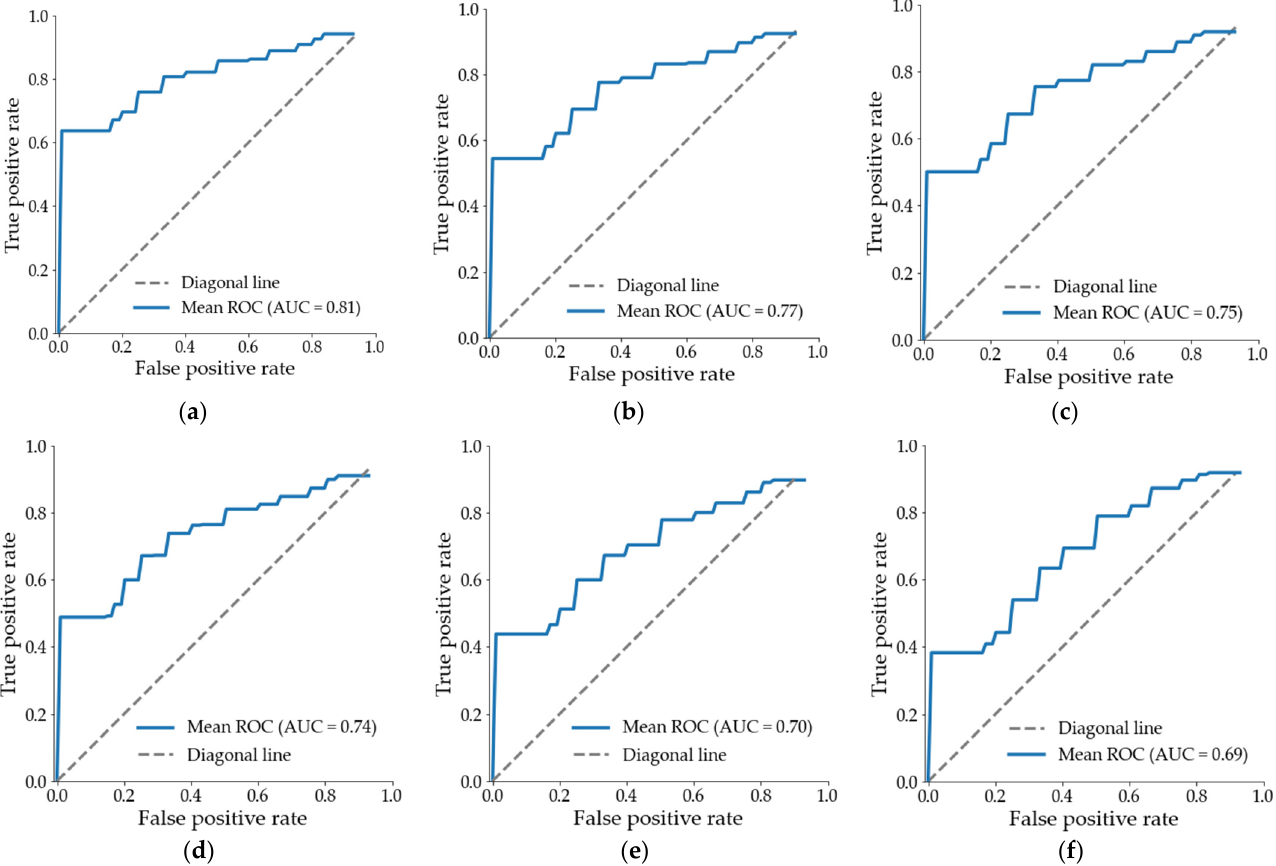
Figure 10. The average ROCs of the logistic models on May 3. ( a – f ) The average ROCs of models with spectral features and texture features extracted from window sizes of 5 × 5, 9 × 9, 13 × 13, 17 × 17, 21 × 21, and 25 × 25 pixels.